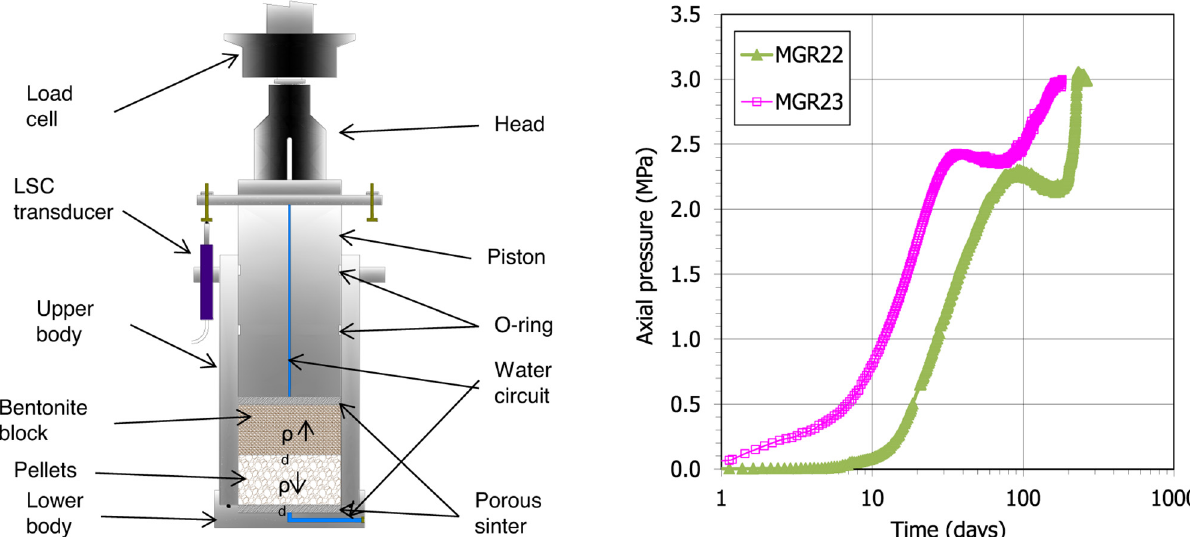
Fig. 6. Isochoric cell for hydration tests on bentonite block/pellets and swelling pressure evolution in two